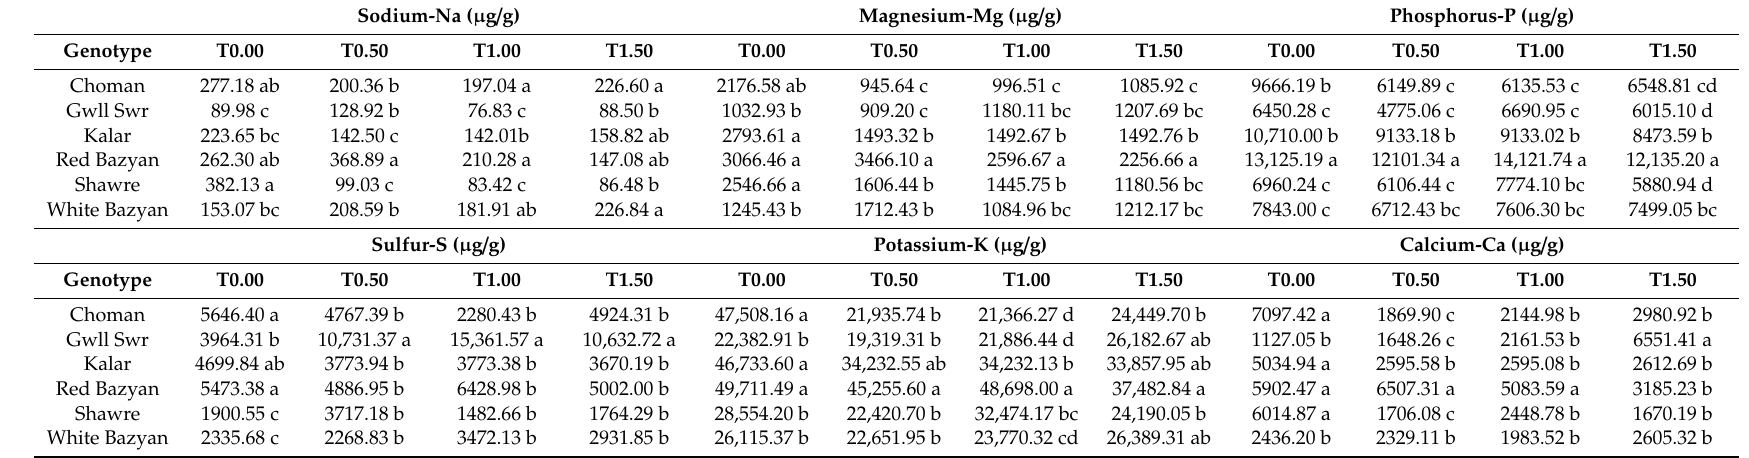
Table 9. Accumulation of elements in callus under control and drought stress conditions. The results displayed are an average of six replicates. Dissimilar letters within a column indicate a statistical variation between mean values using Duncan’s multiple-range test ( p ≤